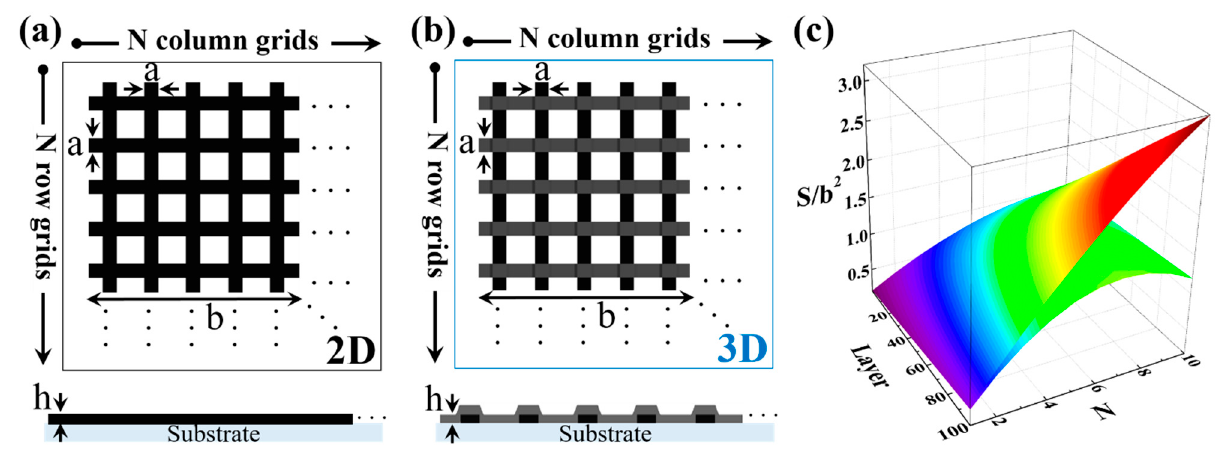
Figure 3. Numerical analysis of 3D pattern. ( a ) 2D model of pattern. ( b ) 3D model of pattern. ( c ) Specific surface area of 2D and 3D.